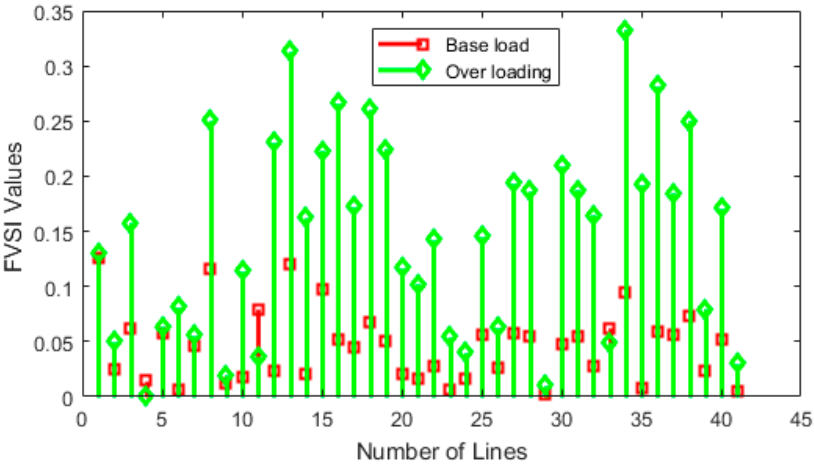
Figure 4. Fast voltage stability index (FVSI) values against 1.6 loading factor. Table 2. Top five weakest buses associated with higher values of fast voltage stability index (FVSI). S.No Line Number FVSI Value Bus No. 1 8 0.2506